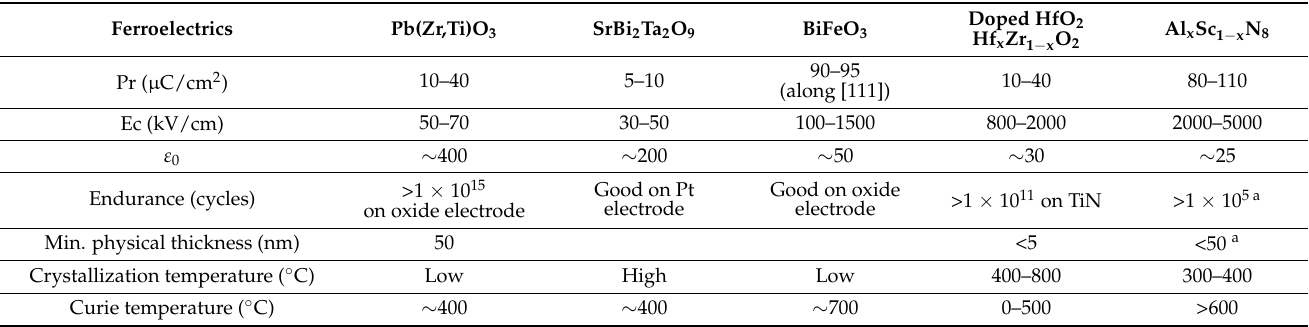
Figure 4. Classic ferroelectric materials: Pb(Zr,Ti)O 3 , SrBi 2 Ta 2 O 9 , and BiFeO 3 [34]. Table 1. Comparison of ferroelectric materials: PZT, SBT, BFO, doped HfO 2 , Al x Sc 1 − x N. [34].